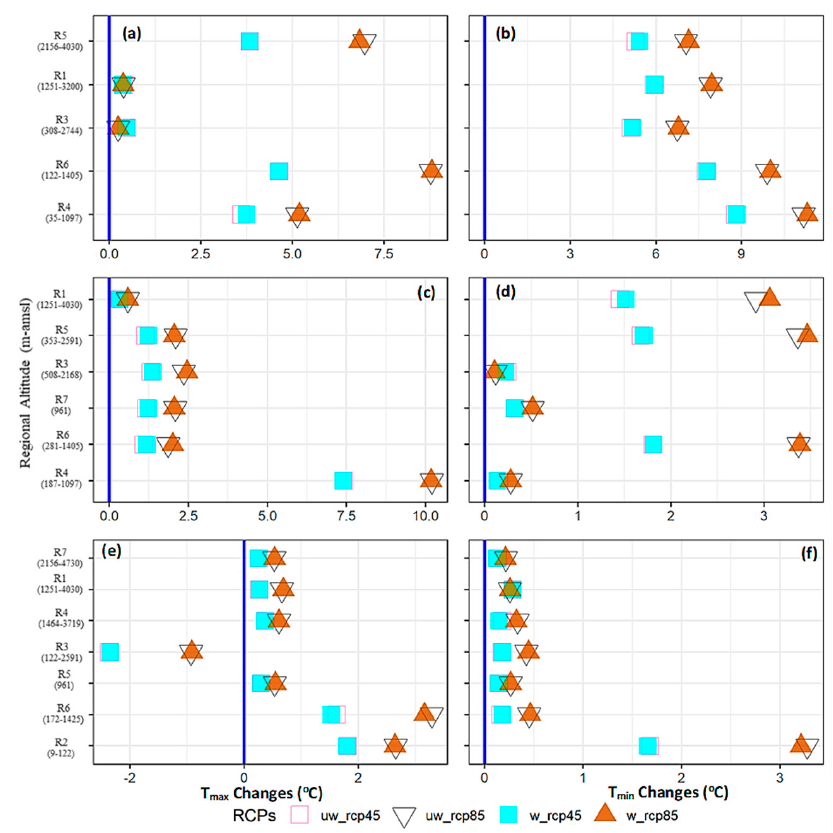
Figure 6. Impact of the model weighting on ensemble changes (MMEs) during 2071–2100 under both RCPs. ( a , b ) show weighting impact during the WS for T max and T min , respectively. Similarly, the PMS ( c , d ) and the MS ( e , f ) weighting impacts are also shown. In the legend, “unw_” stands for the unweighted and, “w_” shows weighted changes for both RCP scenarios.